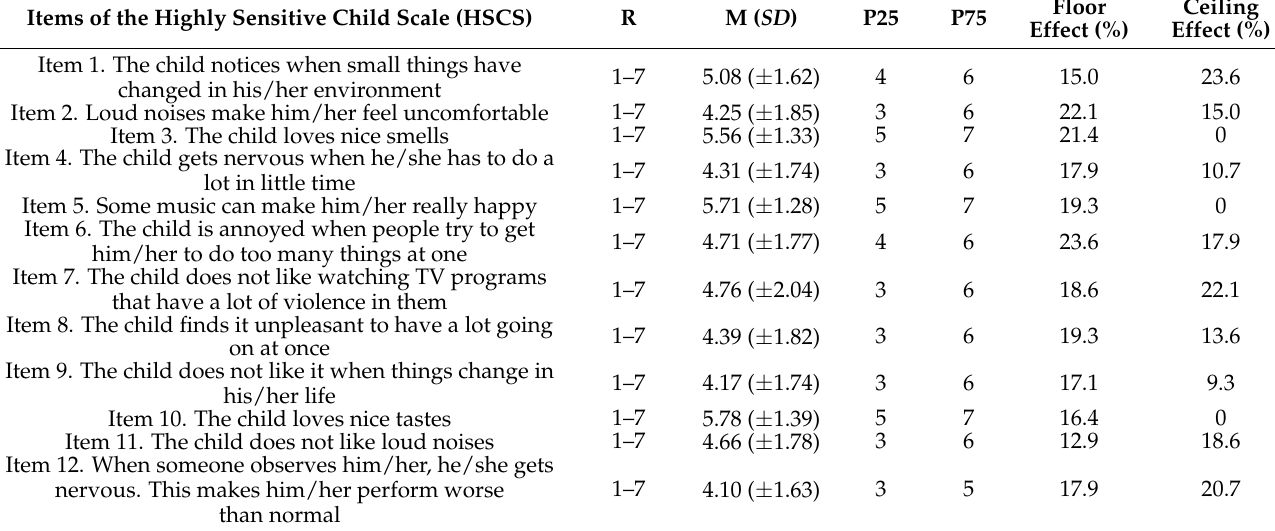
Table 1. Performance of the scale and related normative data.